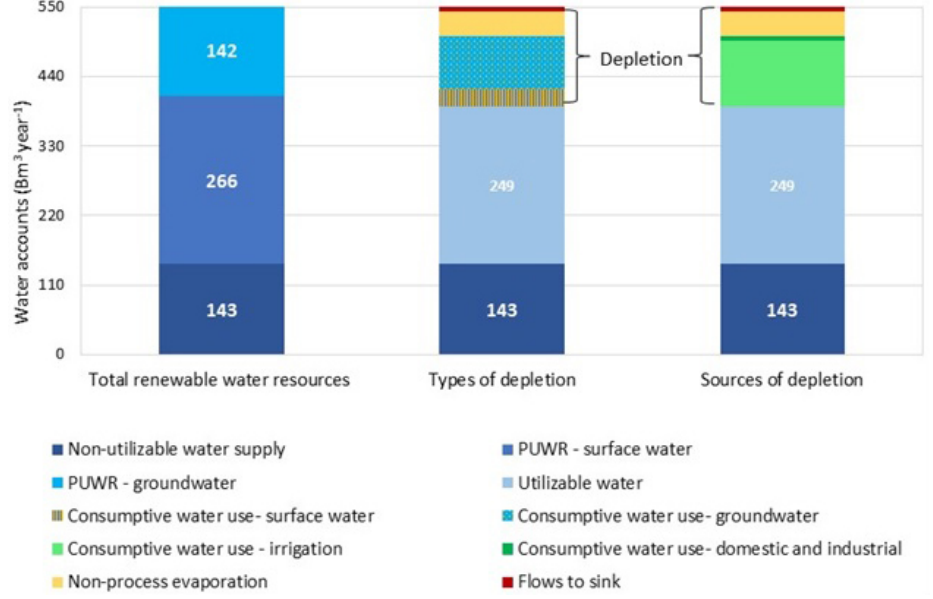
Figure 2. Water use accounts in the Ganges River basin. Sources: utilizable surface water, groundwater and non-utilizable water figures are from the GoI (1999). Other water accounting figures are the authors’